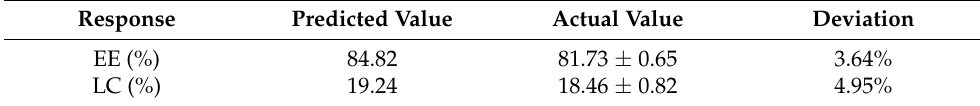
Figure 2. The 3D response surface plots diagrams of EE ( A – C ) and LC ( D – F ). X 1 , X 2 , and X 3 represent the concentration of Solutol HS 15, DSPE mPEG2k, and propofol, respectively. Table 5. Predicted and experimental values for the optimized